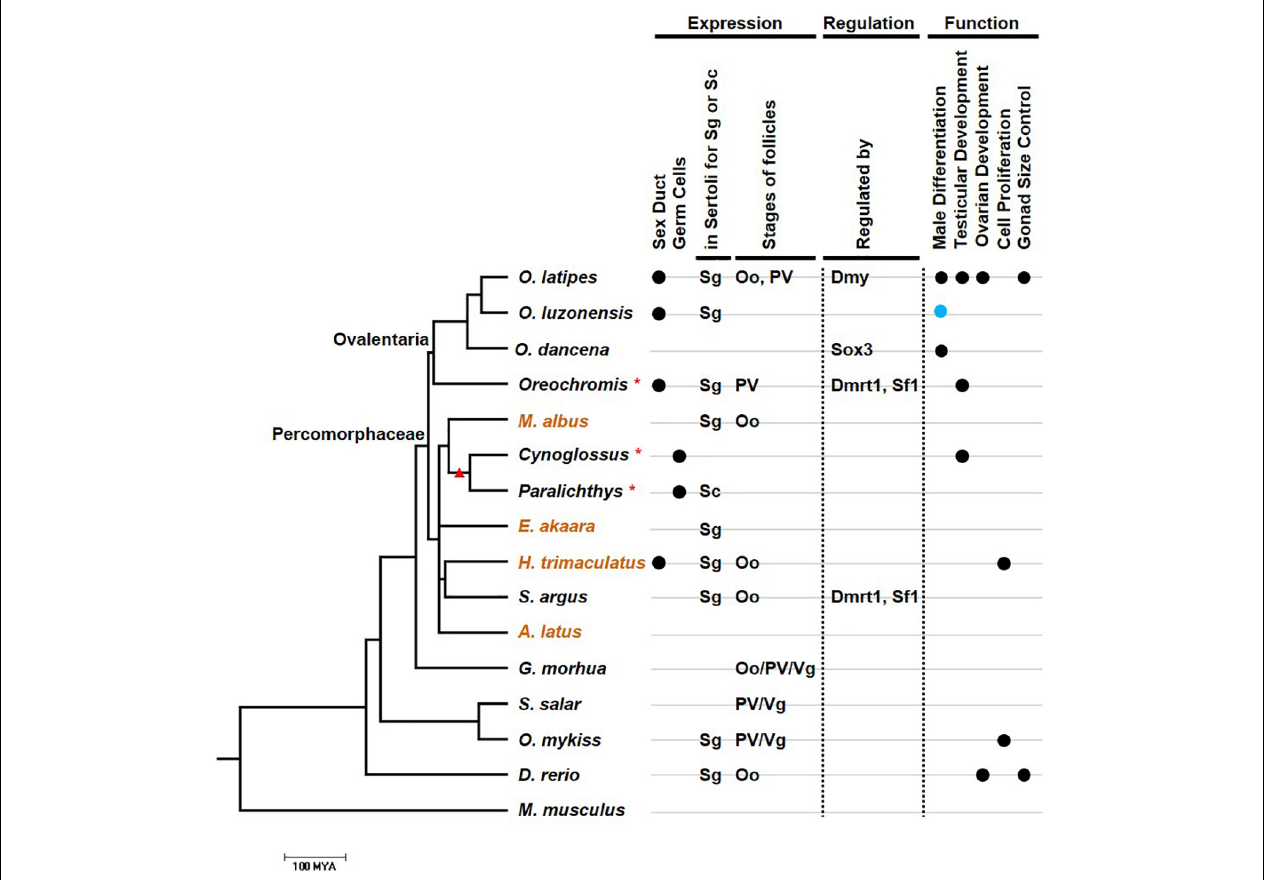
FIGURE 4 | The relationship between the expression, regulation, function, and evolution of gsdf . The phylogenetic tree was drawn using information from the TimeTree database (http://www.timetree.org/resources). Species in the tree including those with gsdf expression in either Sertoli cell in testis or granulose cell in ovary. Mus musculus which does not have gsdf is an outgroup. Scale bar refers to 100 million years ago (MYA). When the evolutionary data of a particular species is missing in the TimeTree database, its genus is used for the compilation of the phylogenic tree and marked with an asterisk. These species include O. niloticus (Oreochromis), Cynoglossus semilaevis (Cynoglossus), and Paralichthys olivaceus (Paralichthys). Orange species names indicate hermaphroditic fish. The branch with a red triangle indicates Pleuronectiformes. The condition of additional expression of gsdf , including expression in efferent duct and germ cells, is labeled with black dots at the right part of first and second lane, respectively. The types of germ cells with predominant surrounding gsdf expression are listed in third and fourth lane. Oo, oogonia; PV, pre-vitellogenic oocyte; Sc, spermatocyte; Sg, spermatogonia; Vg, vitellogenic oocytes. The regulators are list in fifth lane while the functions are listed in lanes 6–9. The function of sex determination is labeled with a blue